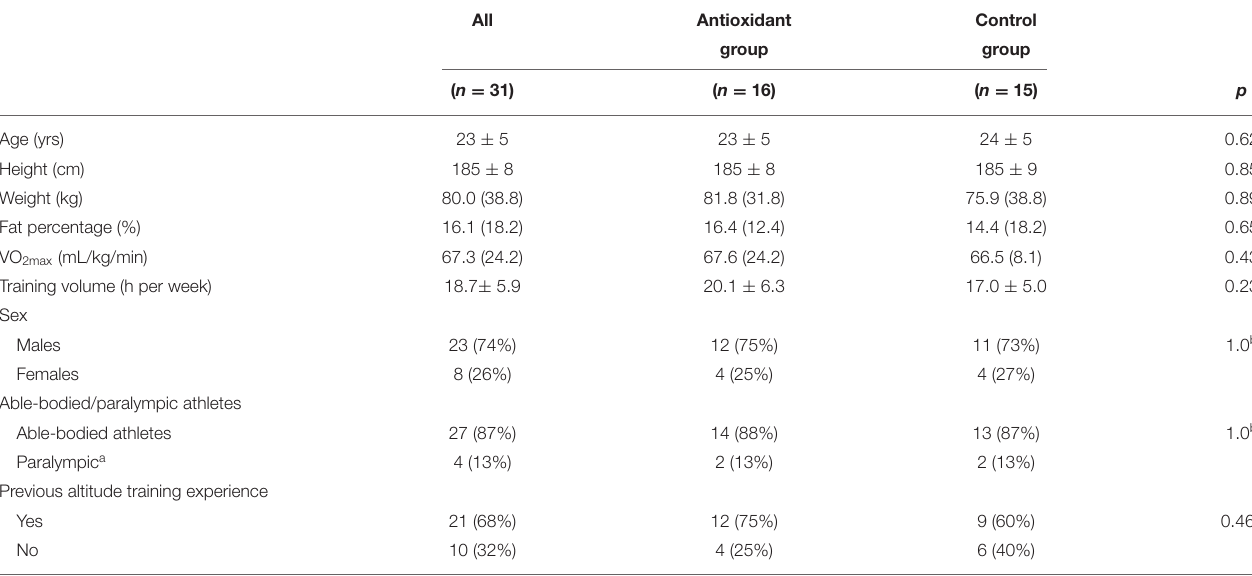
TABLE 2 | Baseline description of the study